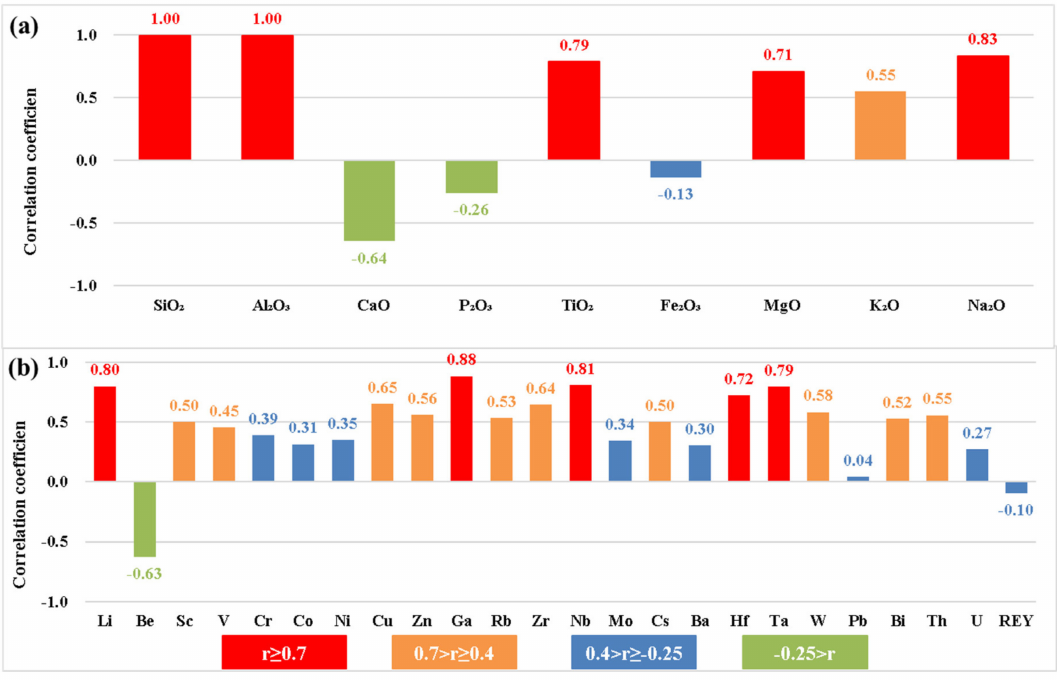
Figure 7. Correlation coe ffi cients between ash yield and elements in Wujiawan coal. ( a ) The correlation coe ffi cients between ash yield and major elements; ( b ) the correlation coe ffi cients between ash yield and trace